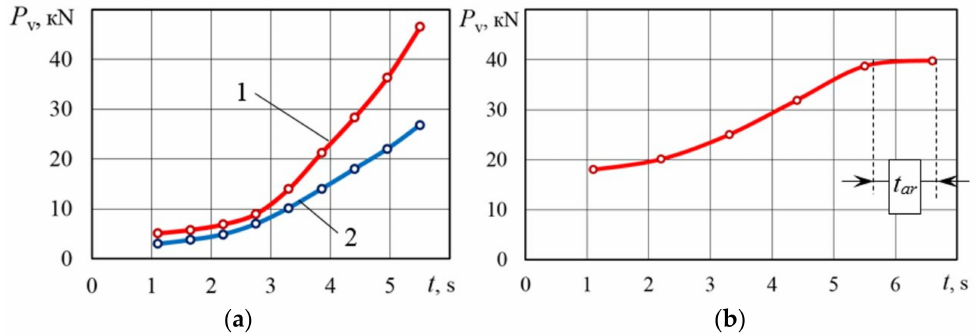
Figure 6. Change in the vertical force on the rotor during the half-cycle: ( a ) 1 − V s = 104 m/h, V c = 6 m/s, t ar = 0 s; 2 − V s = 104 m/h, V c = 9 m/s, t ar = 0 s; ( b ) V s = 104 m/h, V c = 6 m/s, t ar = 1.1